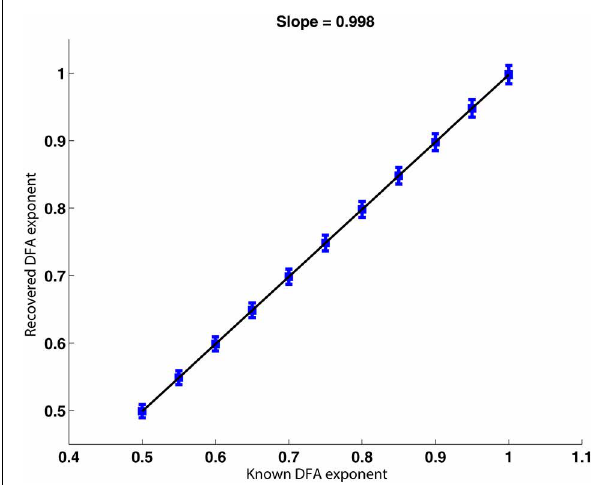
FIGURE 5 | Plot of the recovered against the true DFA exponent for FARIMA time series. The relationship between recovered and true DFA values is well-approximated by a linear trend with a slope of almost 1. The error bars increase very slightly with increasing DFA exponent.